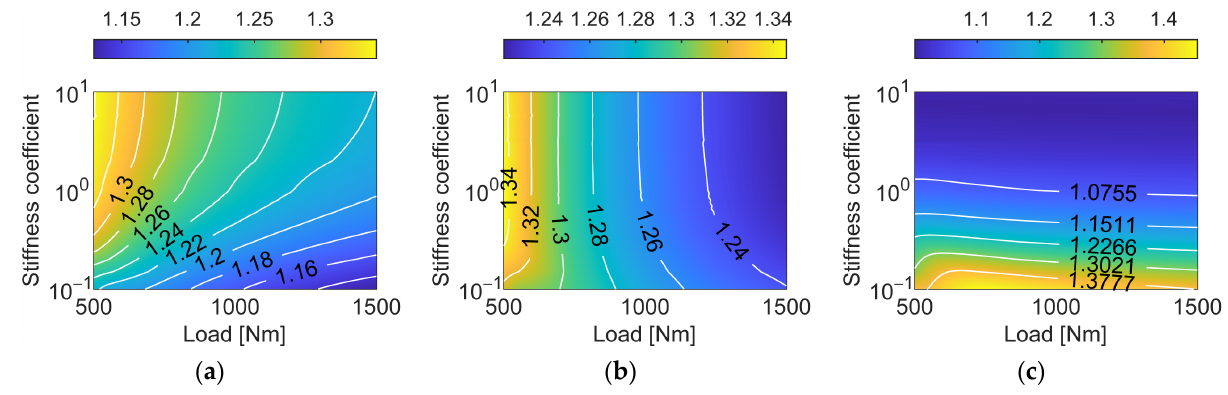
Figure 20. In fl uence of support sti ff ness of upper face gear on load-sharing coe ffi cient: ( a ) Input Gear 1; ( b ) Input Gear 2; ( c ) idler gear.